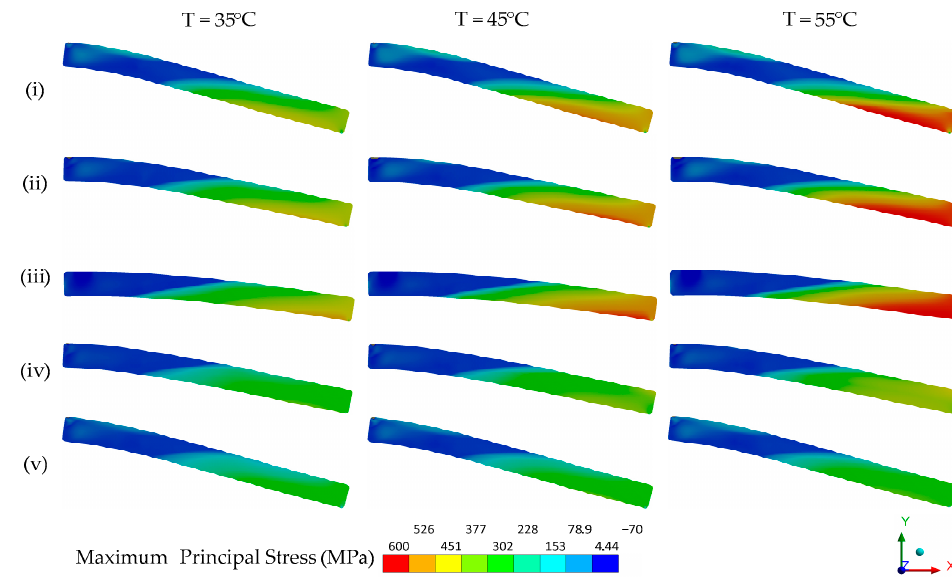
Figure 14. Contour plot of the hoop stress in NiTi Belleville spring.